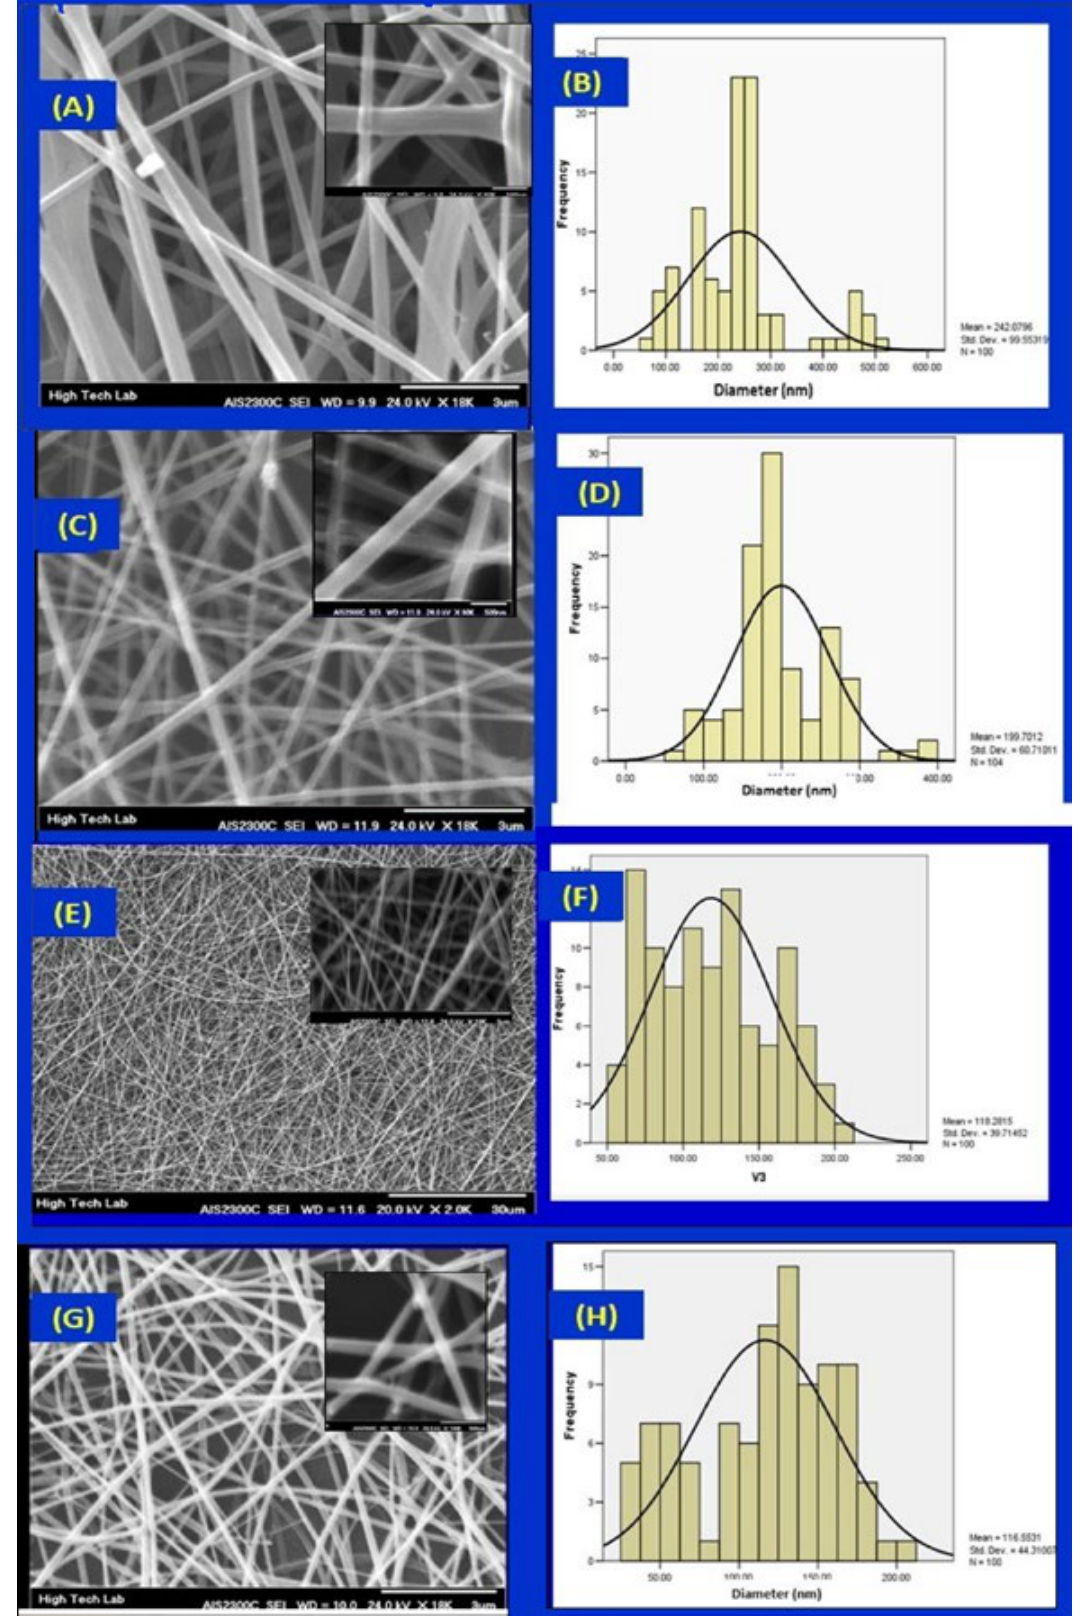
FIGURE 1 - SEM micrographs of (A, B) CS/PEO, (C, D) CS/PEO/Cys, (E, F) CS/PEO/Drugs and, (G, H) CS/